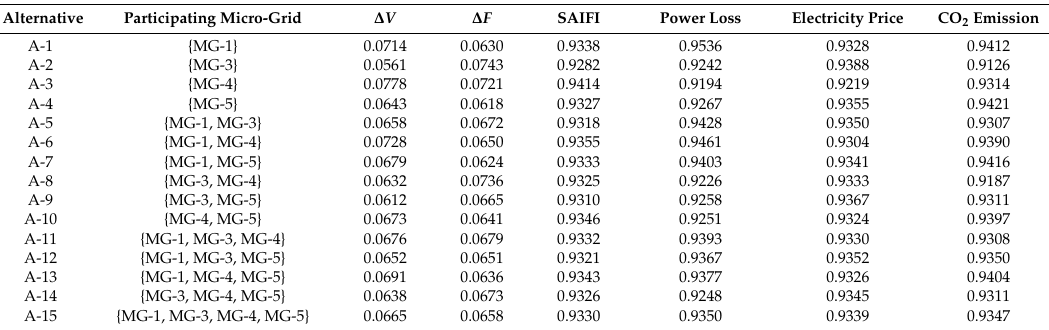
Table 3. The linear normalization